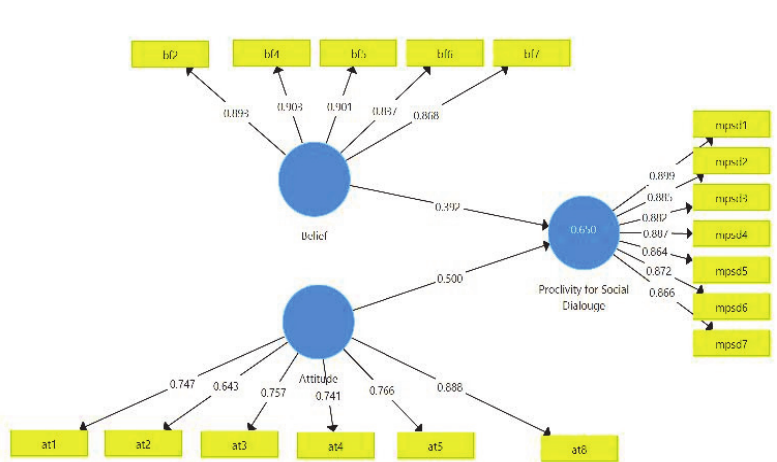
Fig. 3. PLS algorithm report of Smart